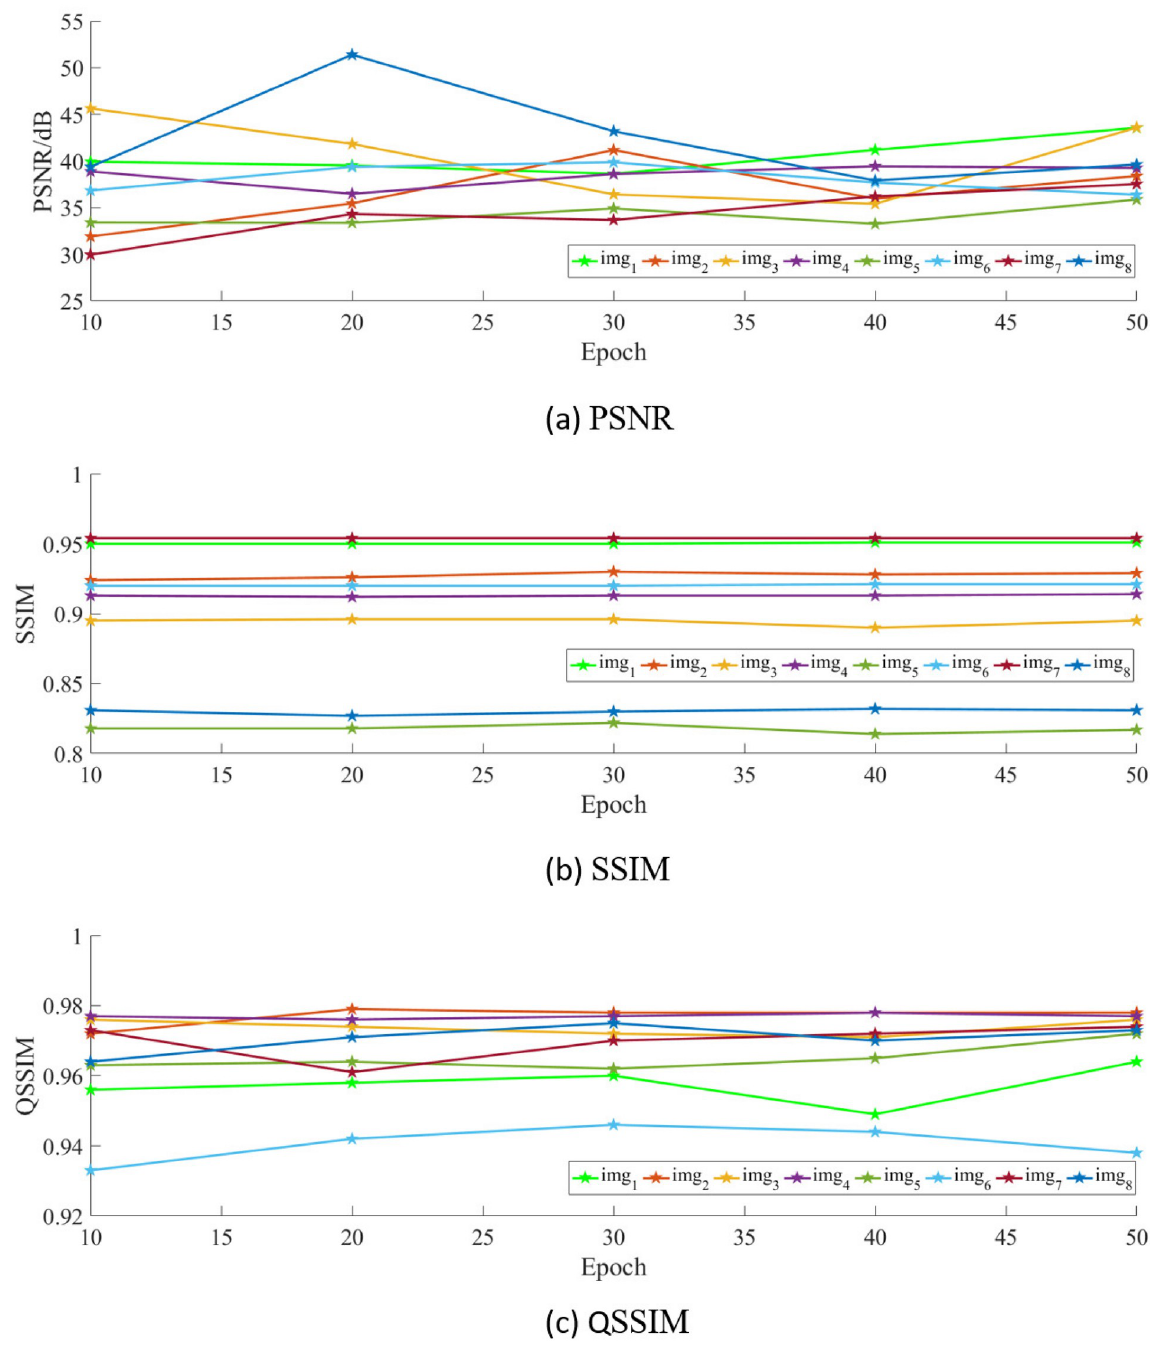
Fig 4. Quantitative evaluation. The data in this figure is from Fig 3, and the images are in the same